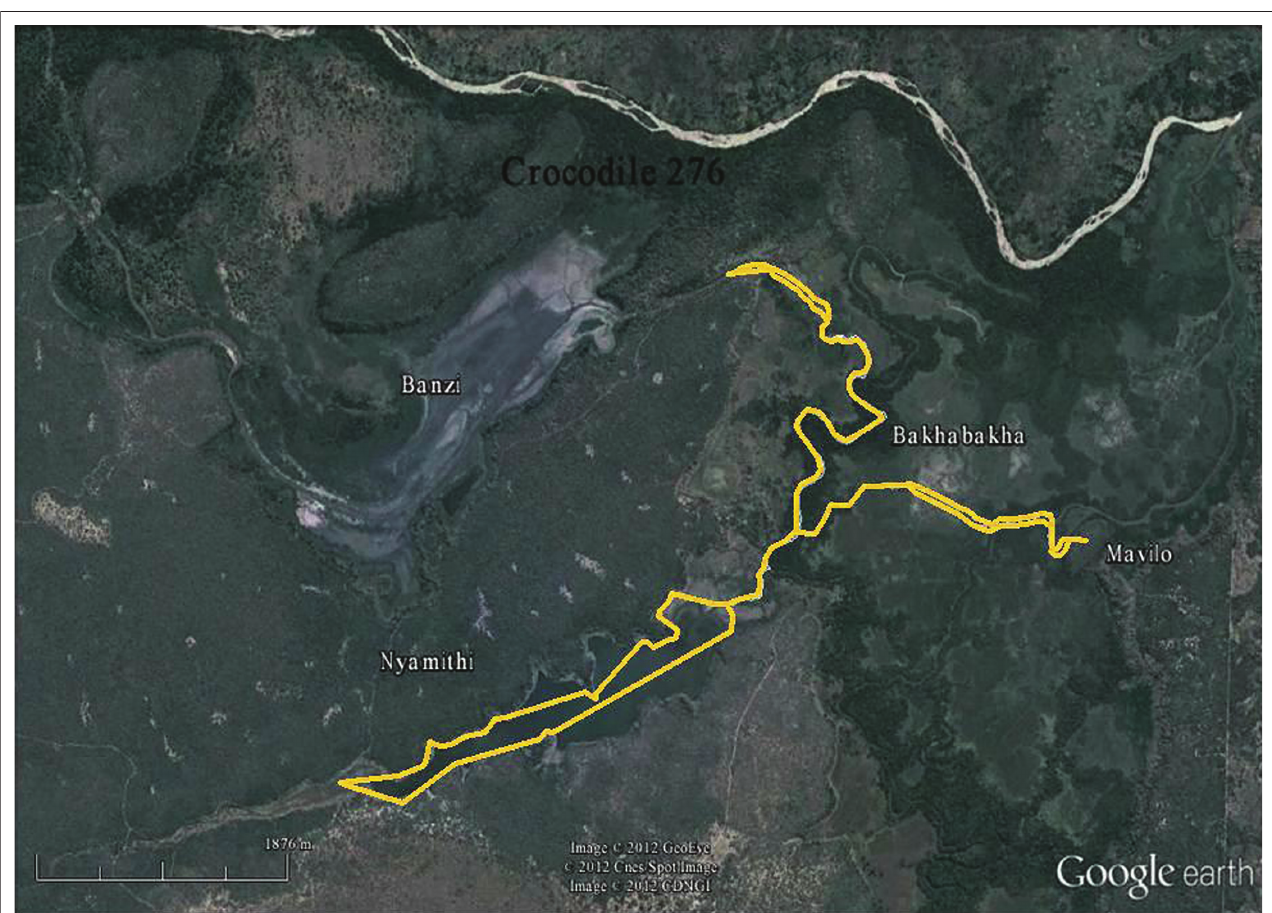
FIGURE A2: Home range of Nile crocodile 276 (yellow line) in Ndumo Game